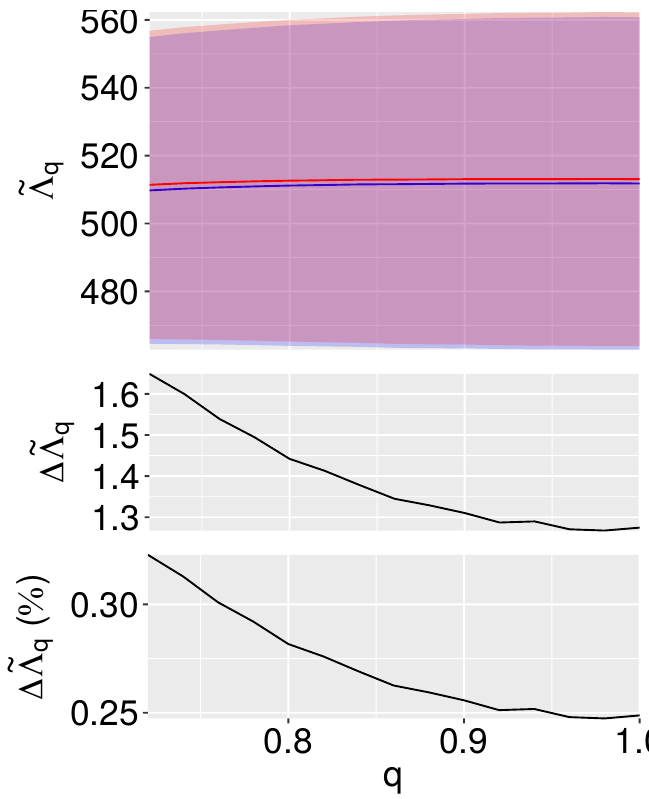
Figure 7. Effective tidal deformability of the binary, ˜ Λ , as a function of q for M chirp = 1.186 M (cid:12) . The mean (solid line), ± 2 σ (filled region), and max/min values (dashed lines) are shown for each dataset, P ( µ ) (blue) and P ( (cid:101) )